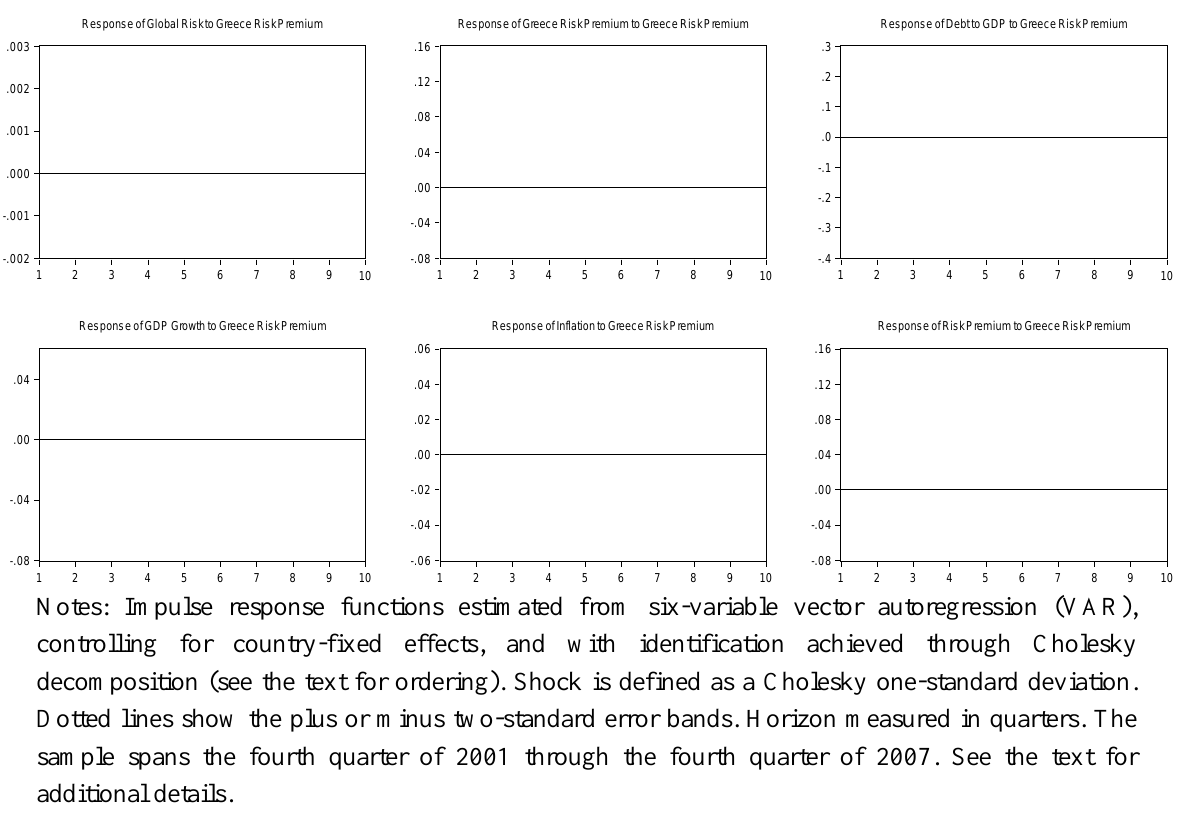
Figure 4. Pre-crisis response of EMU countries to a shock to the Greece risk premium: